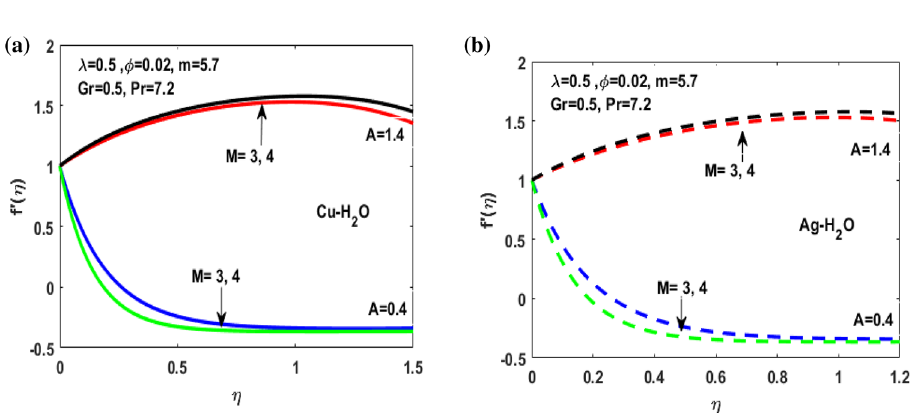
Figure 7. ( a ) Variation of M for f ′ (η) . ( b ) Variation of M for f ′ (η) .